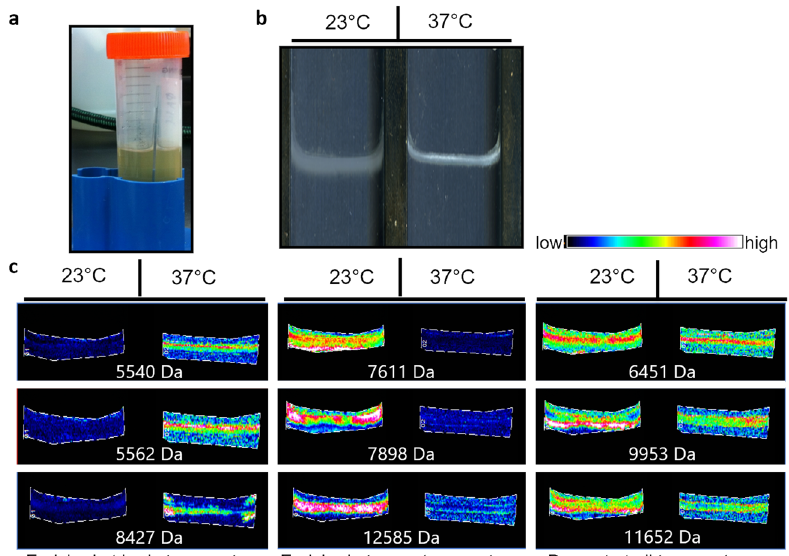
Fig. 2 Proteomic analysis reveals global changes in bio fi lm-associated protein driven by differences in growth temperature. a Pellicle bio fi lms were grown on glass slides at different temperatures. b Bio fi lms were grown on conductive glass slides for analysis by matrix-assisted laser desorption/ionization imaging mass spectrometry (MALDI IMS). c MALDI IMS revealed dramatic temperature-dependent changes in protein abundance and distribution in pellicle bio fi